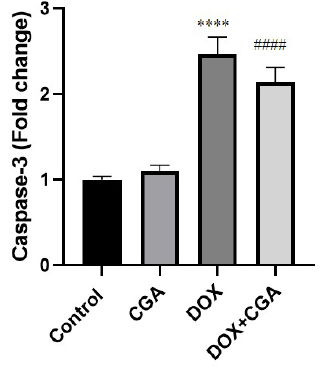
Figure 7. Apoptotic marker in cardiac tissue. The caspase-3 mRNA expression levels were signifi- cantly decreased with CGA treatment. Data are presented as the means ± SD. **** p < 0.0001 vs. the control group, #### p < 0.0001 vs. the DOX group (n = 7). CGA: Chlorogenic acid (100 mg/kg); DOX: Doxorubicin (15 mg/kg).